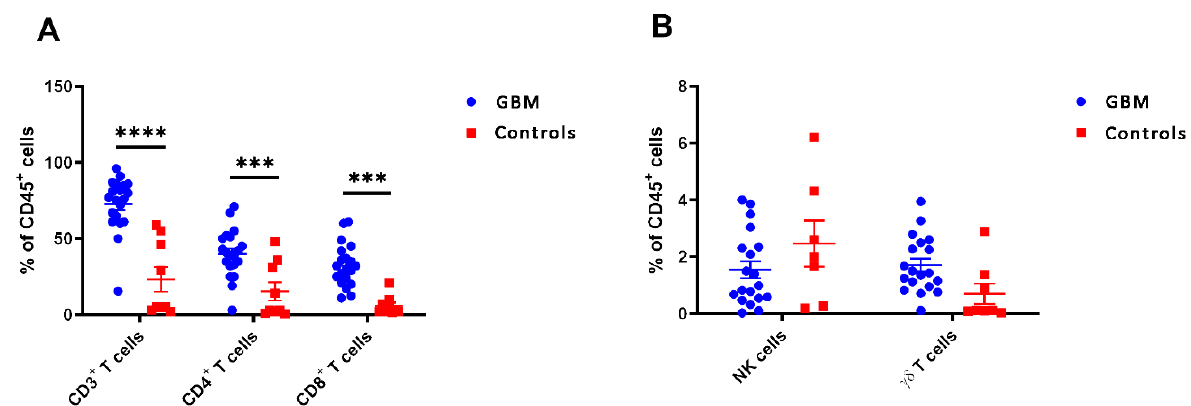
Figure 1. Cumulative analysis of the immune infiltrate of n = 20 GBM samples. The lymphocyte populations were identified by analyzing the expression of cell surface markers. ( A ) show the percentage of CD3 + , CD4 + helper and CD8 + cytotoxic T lymphocytes, while ( B ) show the percentage of NK and γδ T cells in GBM and control samples. Data are reported as the average percentage value of the total CD45 + viable cells ± SE. Statistical analysis was performed by Multiple t -test Analysis, *** p < 0.001, **** p < 0.0001.